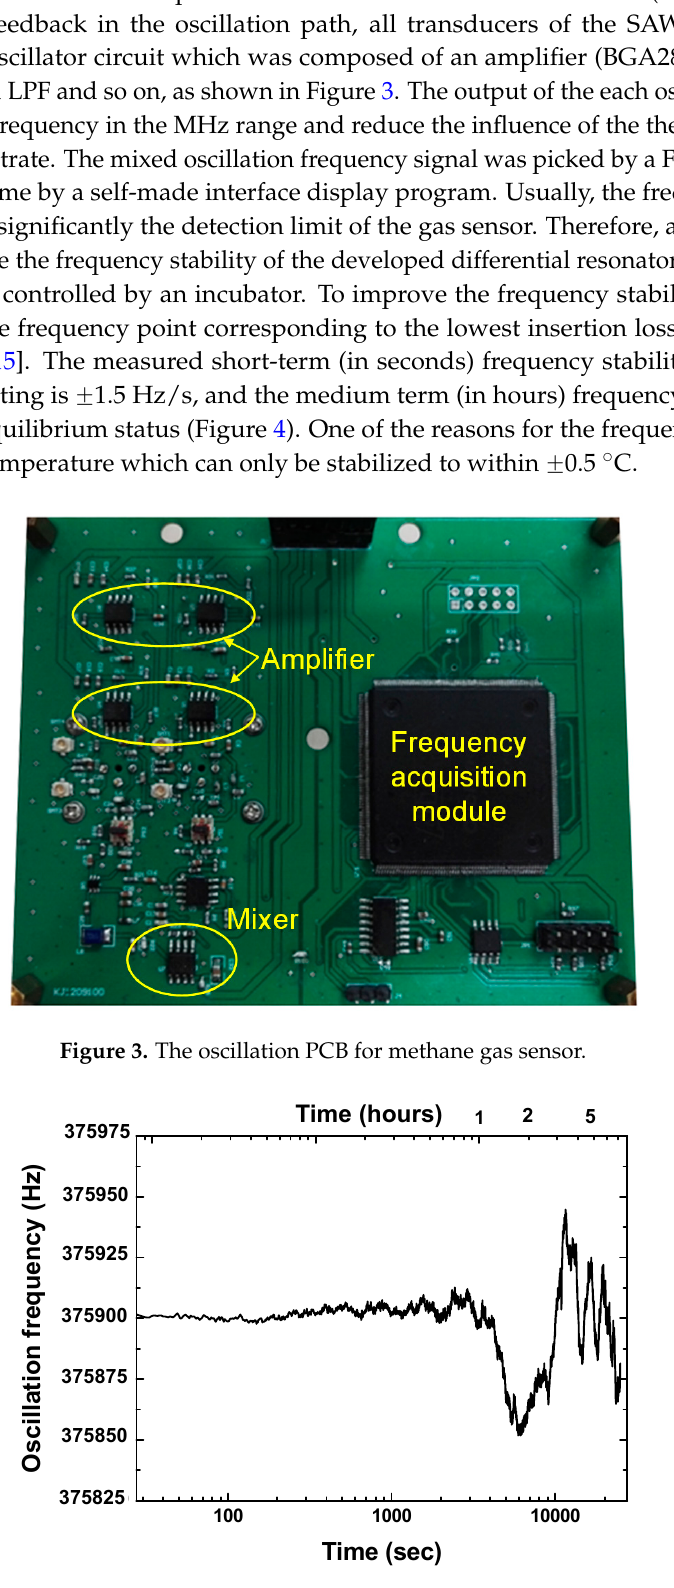
Figure 4. The measured frequency stabiltiy of the SAW oscillator.